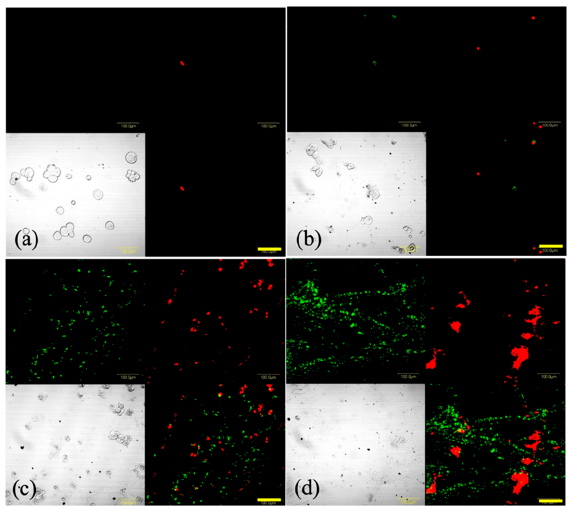
Figure 6. Representative images of SNP cells stained with Annexin V-fluorescein isothiocyanate (green) and ethidium homodimer III (red) following photodynamic therapy (PDT). Cells were incubated with 8 μ g/mL glucose-conjugated chlorin e6 (G-Ce6) for 24 h. Following washing with fresh medium, the cells were irradiated with 650-nm laser light (10 mW/cm 2 ; 0, 1, 5, or 15 J/cm 2 ). Following 4 h of PDT, the cells were stained using the Promokine Apoptotic/Necrotic Cells Detection kit. The images depict ( a ) 8 μ g/mL G-Ce6 and 0 J/cm 2 laser energy, ( b ) 8 μ g/mL G-Ce6 and 1 J/cm 2 laser energy, ( c ) 8 μ g/mL G-Ce6 and 5 J/cm 2 laser energy, and ( d ) 8 μ g/mL G-Ce6 and 15 J/cm 2 laser energy. Scale bar, 100 μ m.